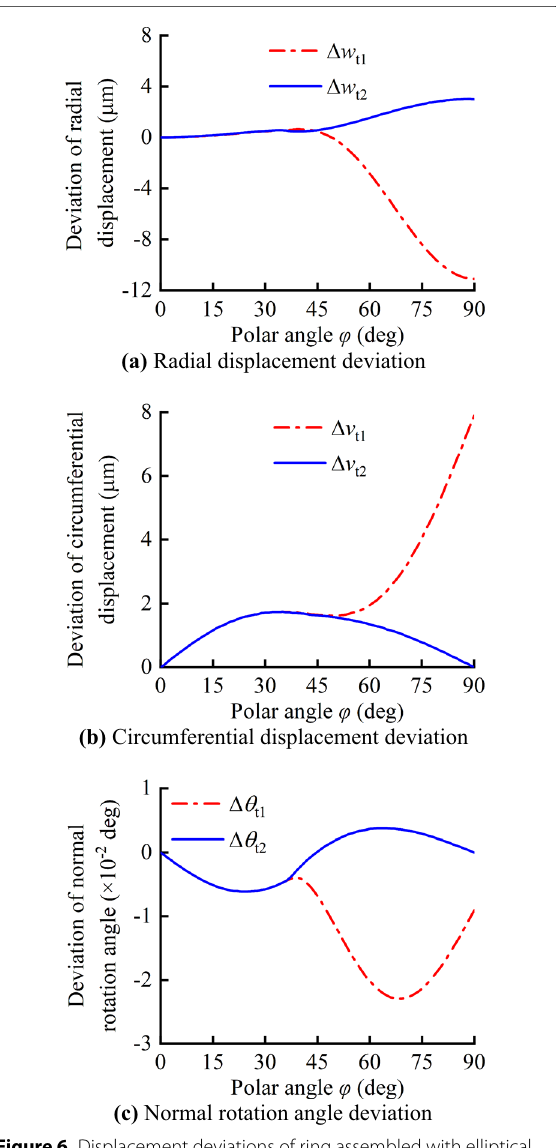
Figure 6 Displacement deviations of ring assembled with elliptical